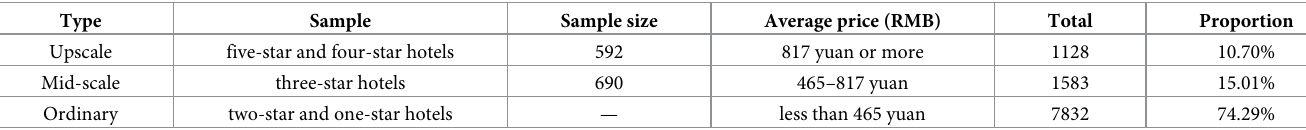
Table 1. The classification of hotels in